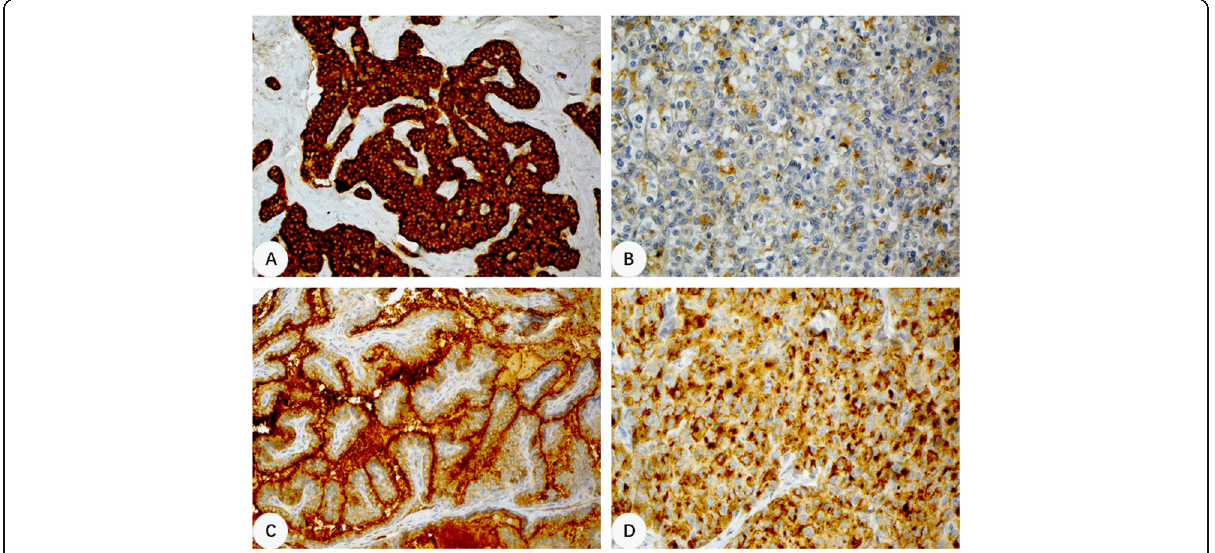
Fig. 2 Immunohistochemical staining patterns of CLU in non-hepatocellular tumors of various origins. a , A pancreatic neuroendocrine tumor showing diffusely strong cytoplasmic and membranous staining (200x). b , A clear cell renal cell carcinoma showing patchy weak cytoplasmic positivity (400x). c , A papillary thyroid carcinoma showing luminal surface staining (200x). d , A breast ductal carcinoma showing cytoplasmic and paranuclear dot-like staining